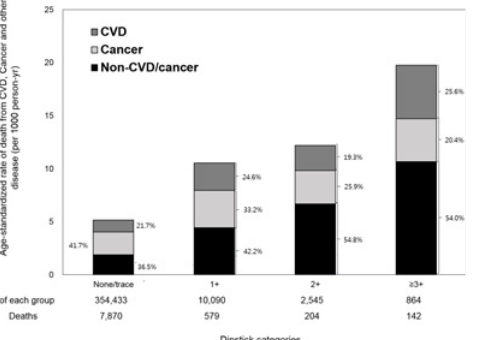
Fig 2. Age-standardized mortality rate (per 1000 person-years) by dipstick proteinuria.